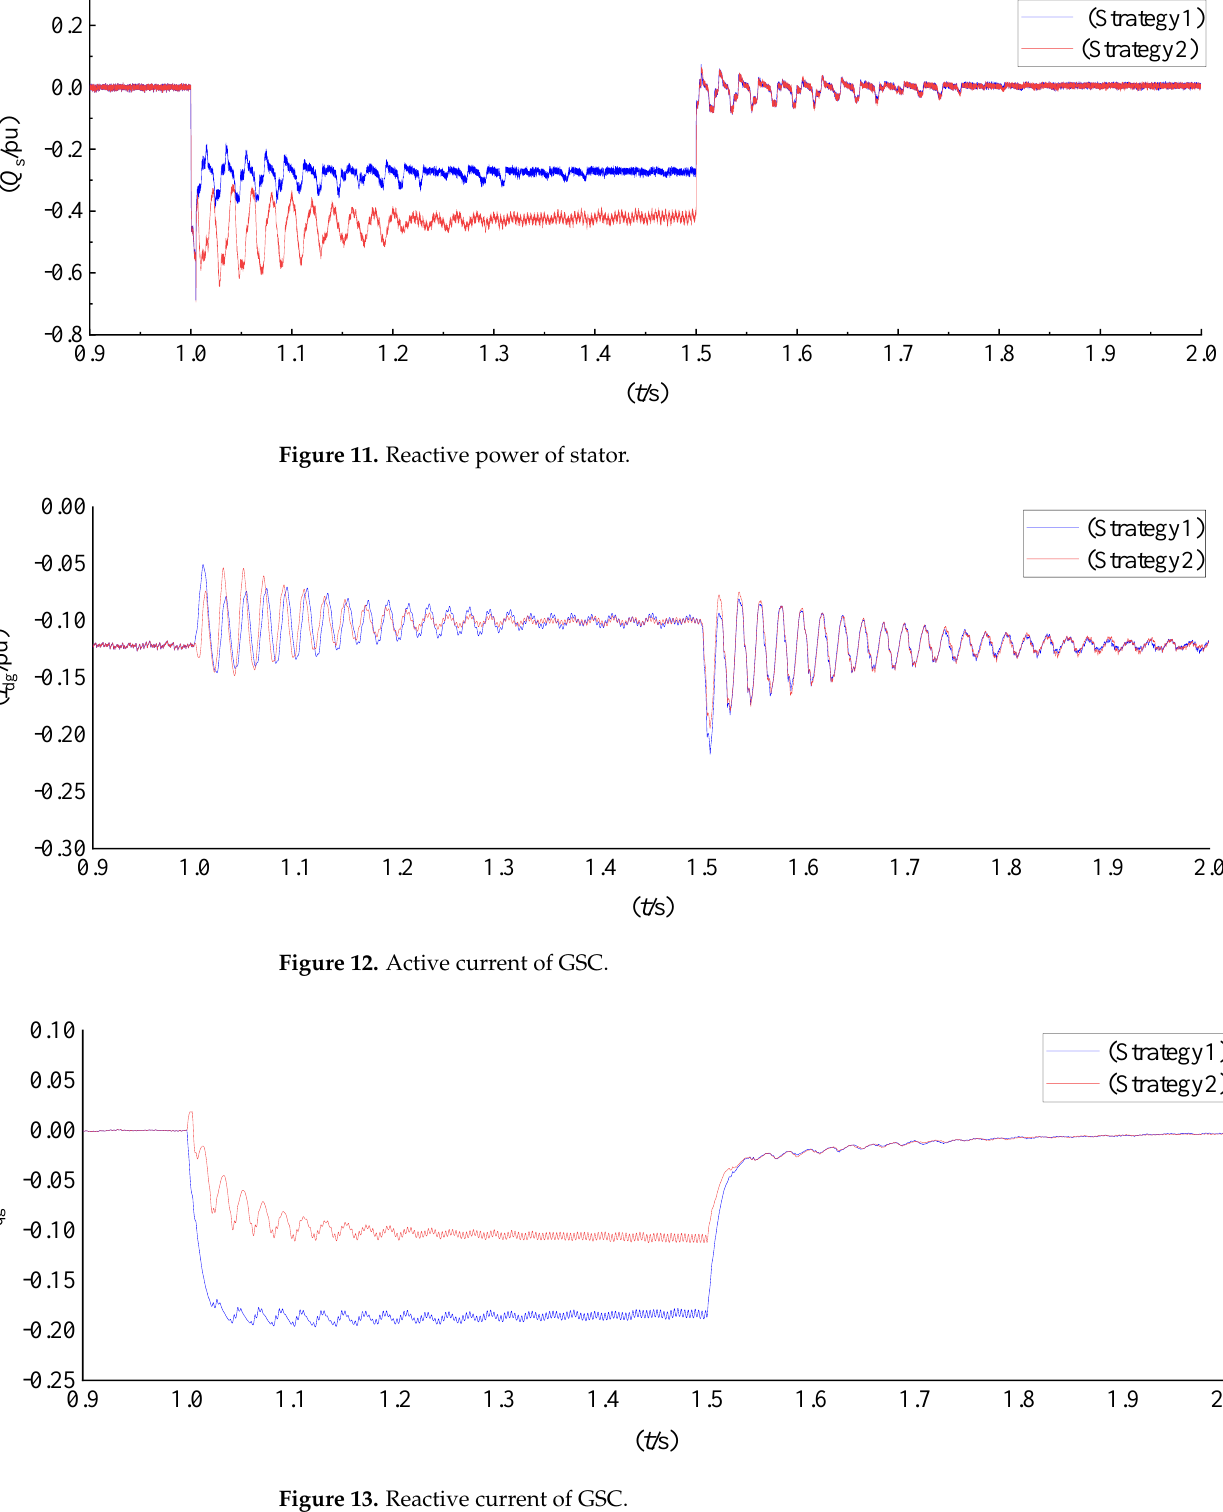
Figure 13. Reactive current of GSC.